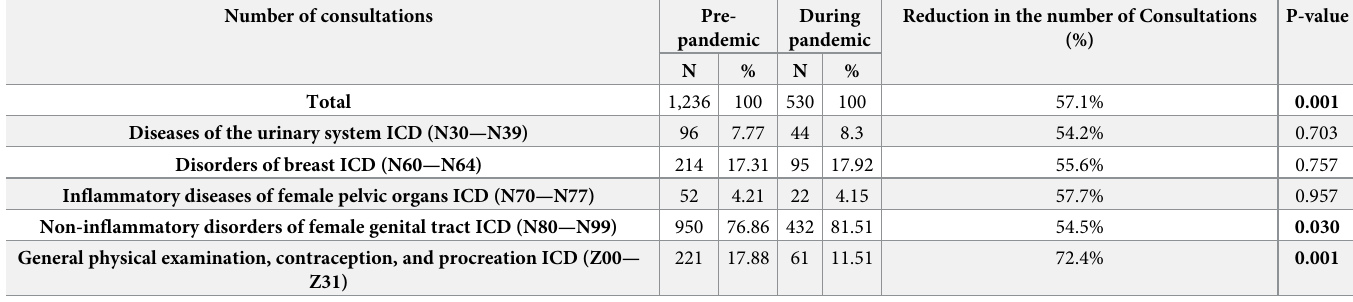
breast (17.92%, n = 95), general physical examination, contraception, and procreation (11.51%, n = 61), diseases of the urinary system (8.30%, n = 44), and inflammatory diseases of female pelvic organs (4.15%, n = 22). The proportional increase in the prevalence of non-